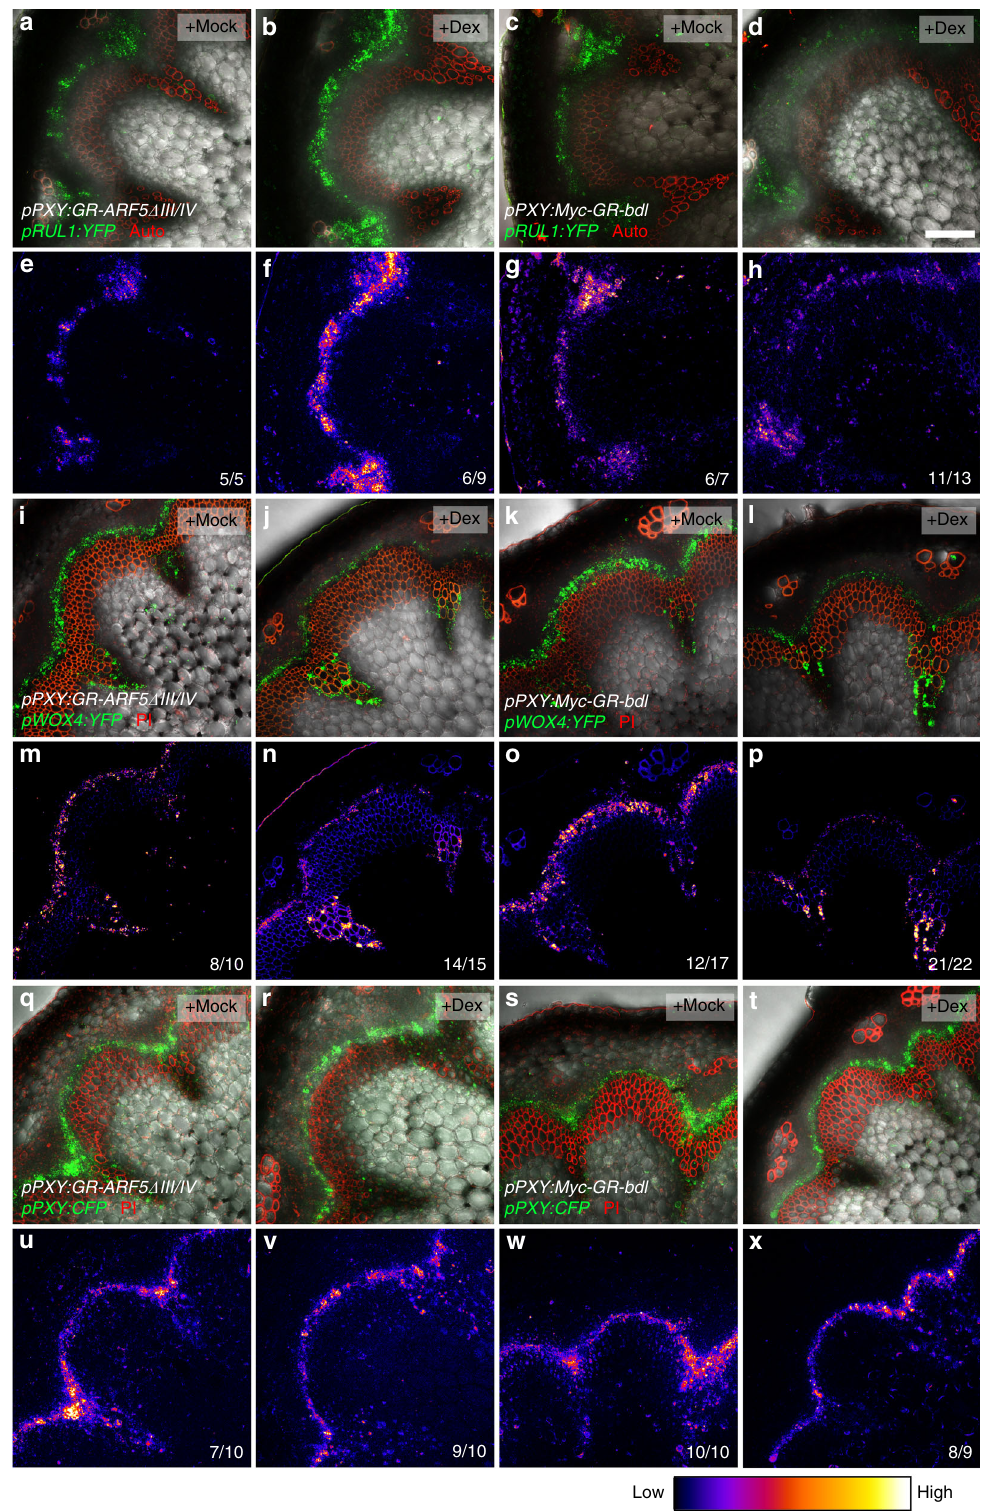
Fig. 5 ARF5 differentially regulates gene activity in cambium stem cells. a – h pRUL1:YFP activity in mock ( a , c , e , g ) and Dex ( b , d , f , h )-treated pPXY:GR- ARF5 Δ III/IV ( a , b , e , f ) and pPXY:Myc-GR-bdl ( c , d , g , h ) lines. i – p pWOX4:YFP activity in mock ( i , k , m , o ) and Dex ( j , l , n , p )-treated pPXY:GR-ARF5 Δ III/IV ( i , j , m , n ) and pPXY:Myc-GR-bdl ( k , l , o , p ) lines. q – x pPXY:CFP activity in mock ( q , s , u , w ) and Dex ( r , t , v , x )-treated pPXY:GR-ARF5 Δ III/IV ( q , r , u , v ) and pPXY:Myc-GR-bdl ( s , t , w , x ) lines. e – h , m – p and u – x show false colour representations of relative intensity of reporter activity displayed in a – d , i – l and q – t , respectively. Colour coding is shown below. Numbers indicate the ratio of sample numbers showing the distinct effects among all samples analysed. Size bar in d represents 100 µ m. Same magni fi cation in all